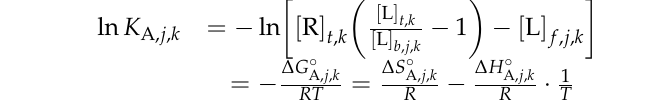
reproduced by a line with negative slope for both polymers indicating a weakly endothermic binding